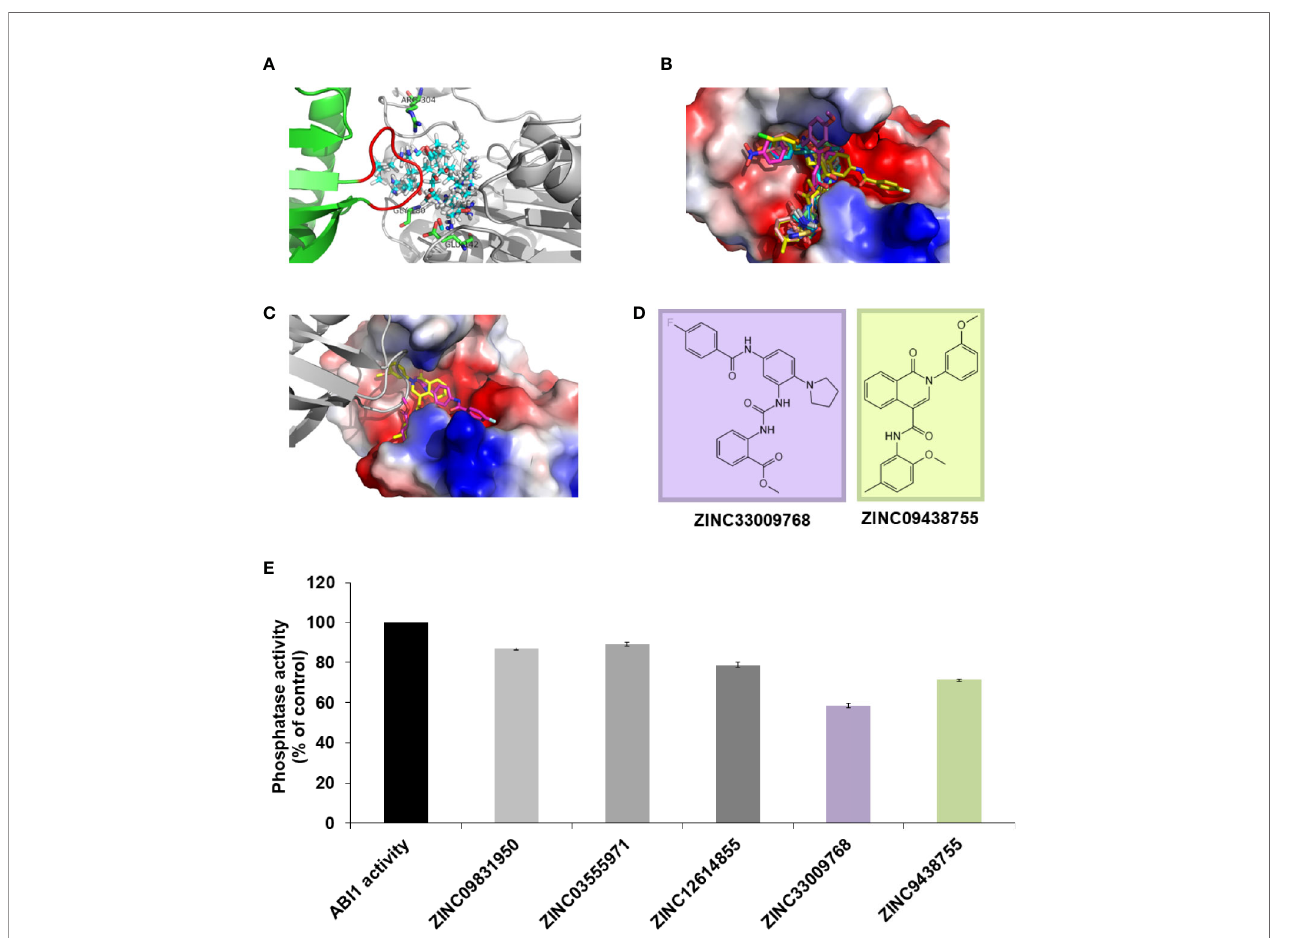
FIGURE 1 | Initial docking study. (A) Protein target ABI1 from crystallographic structure PDB code 3KDJ (complex of PYL1-ABI1) showing proposed binding site (cyan-red-blue sticks) with residues crucial for the interaction labeled; (B) Fifteen chemical compounds from our docking studies were chosen for validation of ABI1 phosphatase activity; (C) In the ABI1 active site, the docking pose of ZINC33009768 is shown as a magenta backbone, and the docking pose of ZINC09438755 is shown as a yellow backbone. PYL1 is shown in gray (the gate-loop of PYL1 is visible adjacent to each chemical compound ZINC33009768 and ZINC09438755); (D) Chemical structure of ZINC09438755 and ZINC33009768 compounds generated in Maestro (Schrödinger Suite); (E) Effect of ZINC33009768 and ZINC09438755 on ABI1 protein phosphatase activity. Normalized results of phosphatase activity are shown in the presence of ZINC09438755 and ZINC33009768, respectively. The enzyme reactions were performed in a 50 µl fi nal volume containing 3 µg of His – ABI1 with or without 100 m M ZINC33009768 or 100 m M ZINC09438755. The results presented are the means from three independent biological